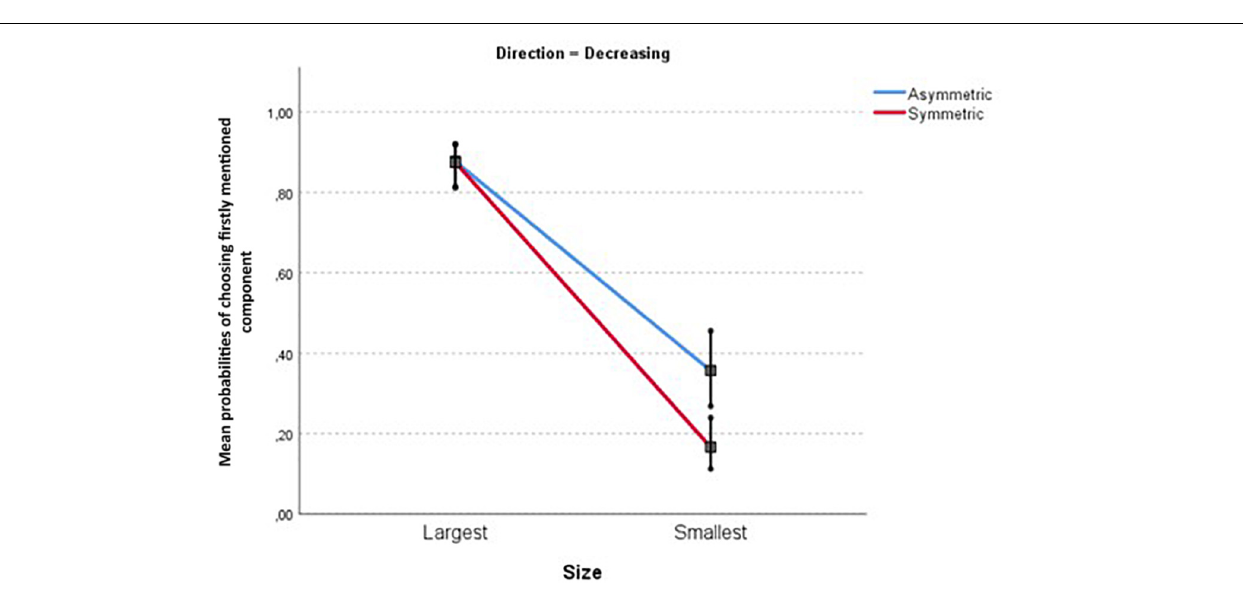
FIGURE 6 | Mean probabilities for the Size × Symmetry contrast for decreasing proportions (see rows 5–8 in Table 3 ). I indicate 95% confidence intervals. Please note that the confidence intervals for the two conditions of decreasing-largest-symmetric (Lower CI = 0.812; Upper CI = 0.919) and decreasing-largest-asymmetric (Lower CI = 0.814; Upper CI = 0.920) can not be visually distinguished from each